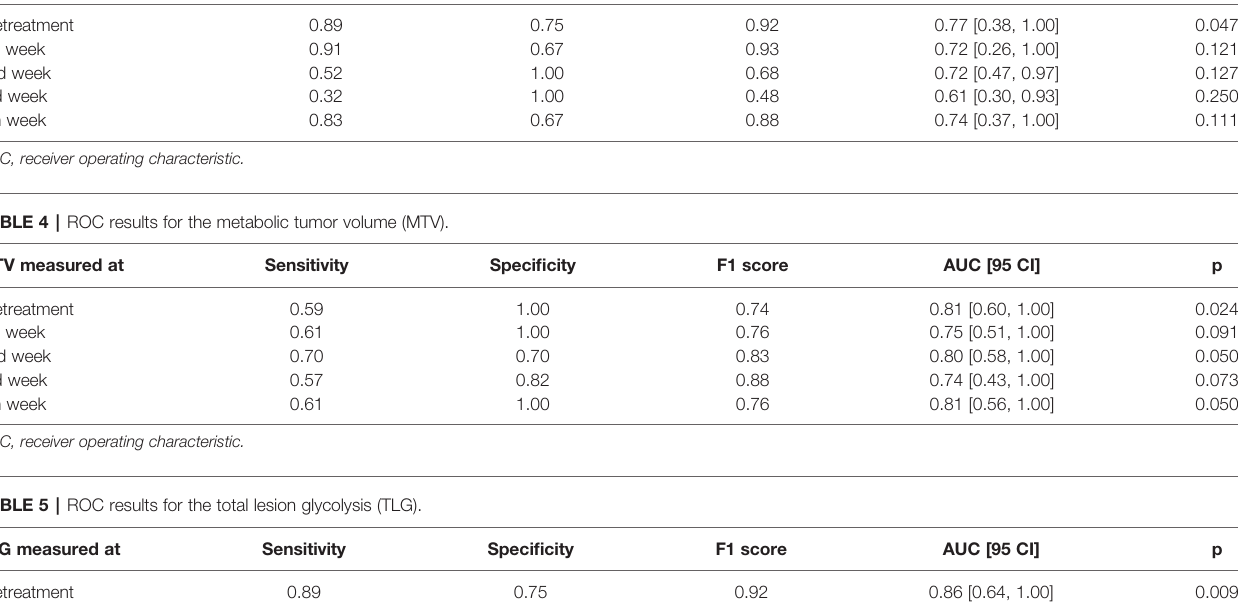
TABLE 3 | ROC results for the maximum SUV (SUV max ). SUV max measured at